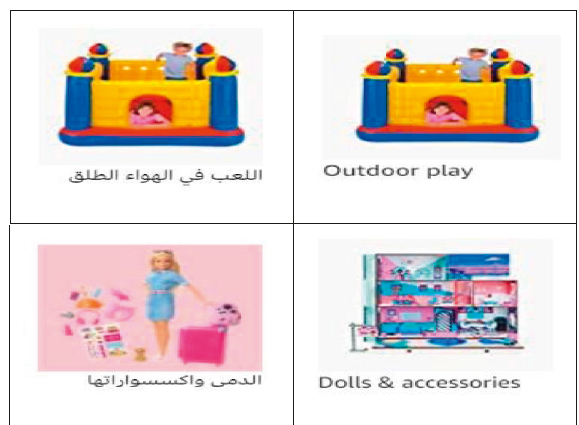
Figure 15: Examples of inconsistent localizations.